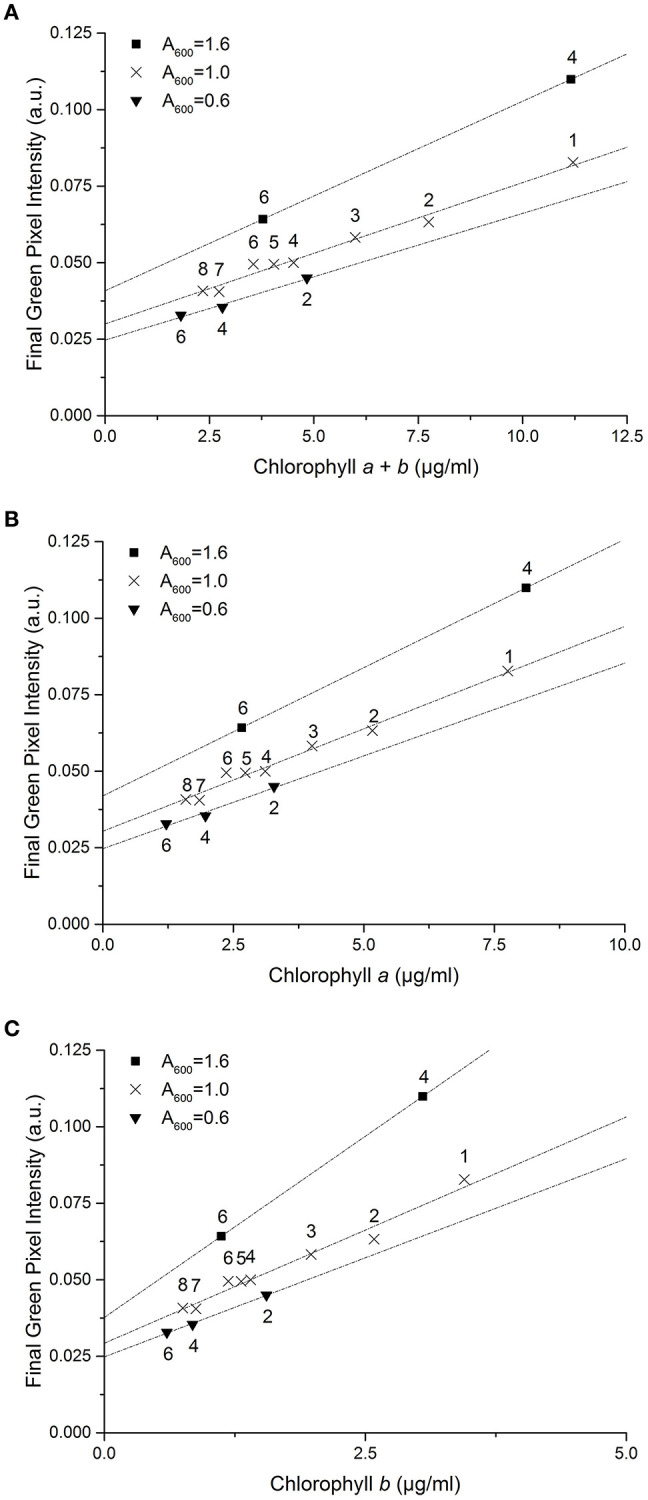
The correlation between final green pixel intensity, calculated from the RGB color method, and (A) chlorophyll a + b, (B) chlorophyll a and (C) chlorophyll b concentrations, as measured by standard extraction method in 80% acetone, for a culture of C. reinhardtii in TAP-N media and photographed over 8 days with three initial starting biomass concentrations as indicated by the different A600 values. Numbers above data points represent the number of days after inoculation that analysis took place. Data points represent the mean green pixel intensity of three photographs (y) and the mean chlorophyll concentration of three sample aliquots (x) and lines represent linear fits through the points.